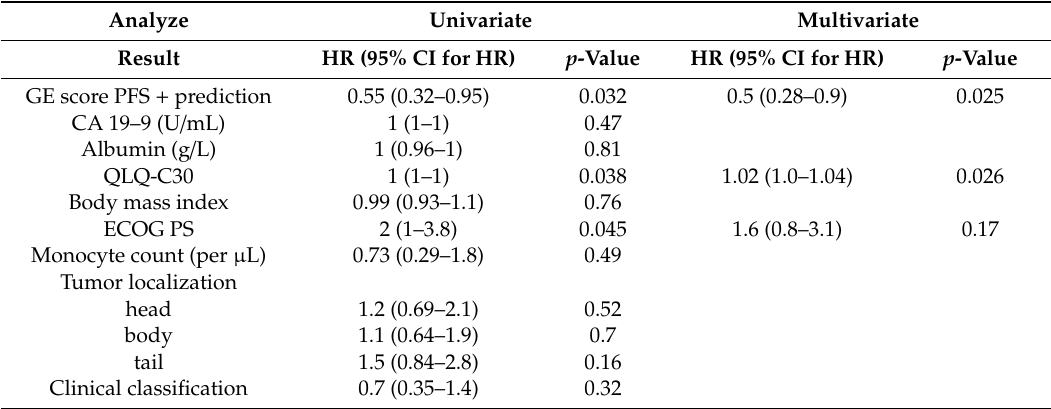
Table 2. Multiple regression analysis of progression free survival factors by multivariable